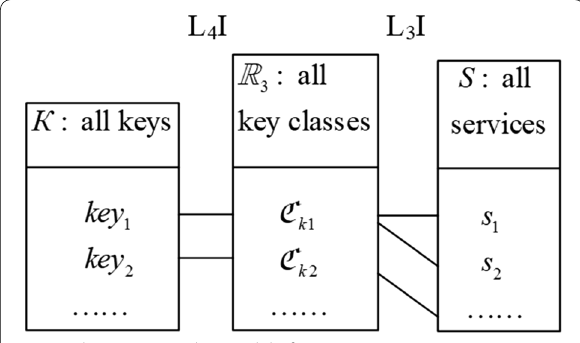
Fig. 8 The primary index model of